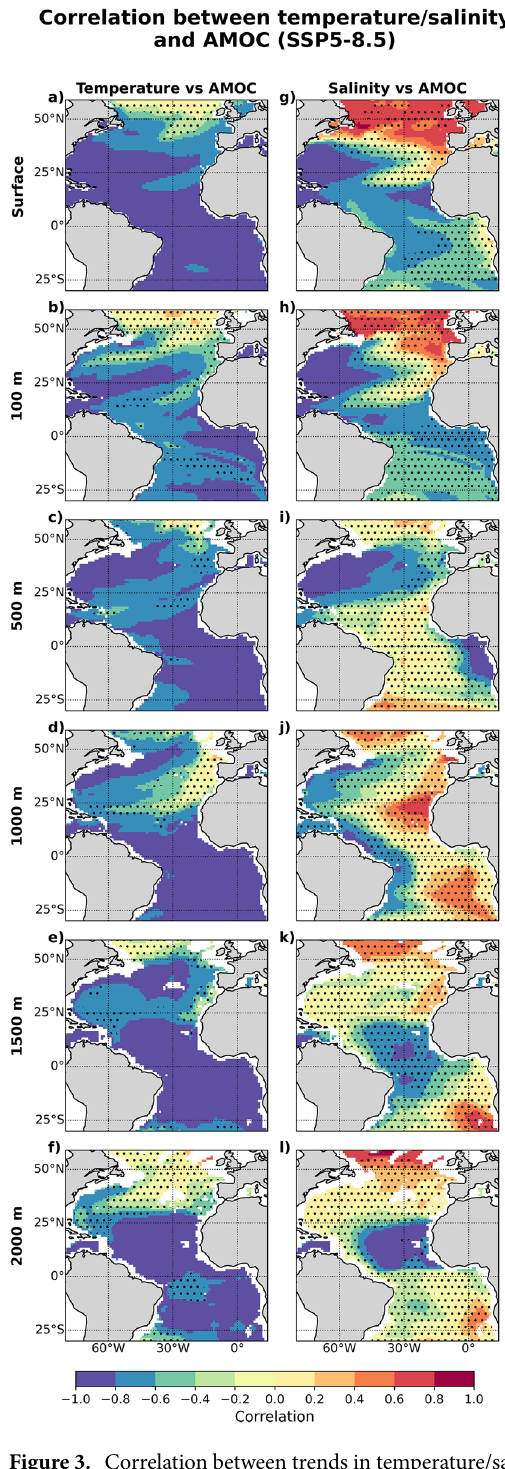
Figure 3. Correlation between trends in temperature/salinity and AMOC strength at 26.5 2015 to 2100 under the SSP5-8.5 scenario, averaged across all models, at ( a , g ) ocean surface, ( b , h ) 100 m, ( c , i ) 500 m, ( d , j ) 1000 m, ( e , k ) 1500 m, and ( f , l ) 2000 m. The stippling marks represent areas where the inter-model standard deviation is above 0.3. Maps were generated with Python 3.9.16 using Matplotlib v3.6.2 (https:// matpl otlib. org/) and Cartopy v0.21.1 (https:// scito ols. org. uk/ carto